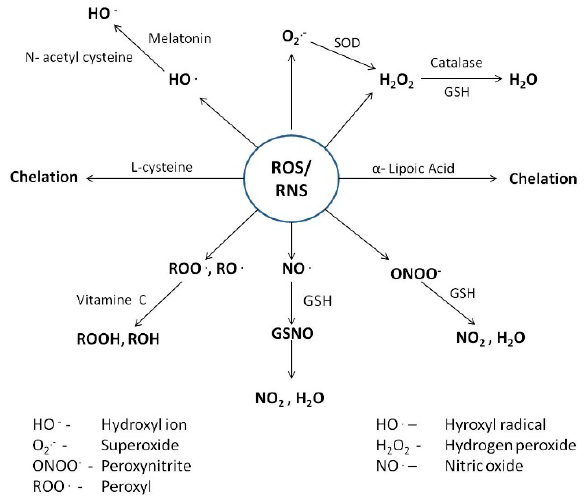
Figure 1. Modes of action of different antioxidants in mitigating the toxic effects imposed by metals.